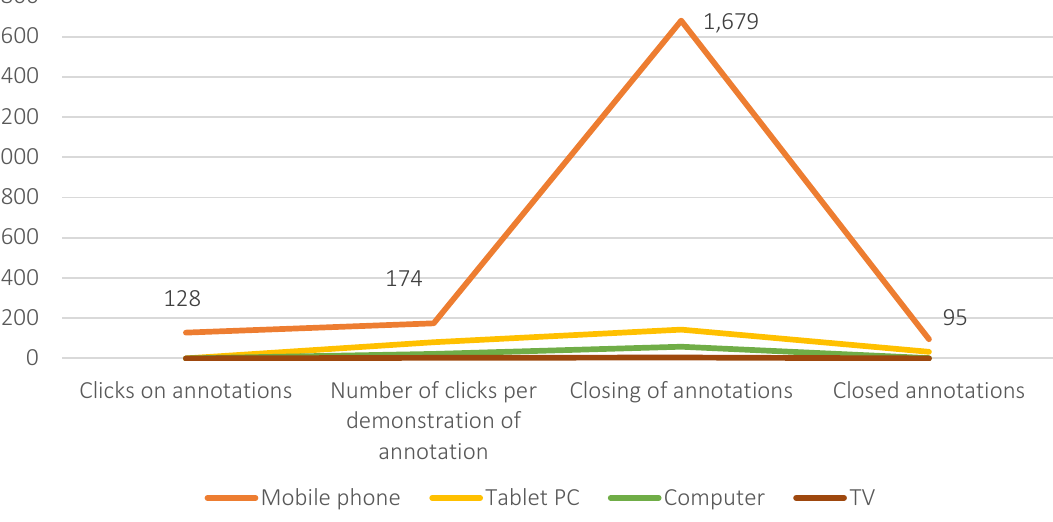
Figure 3. Annotation statistics of video clip demonstration for 21 days of browsing for